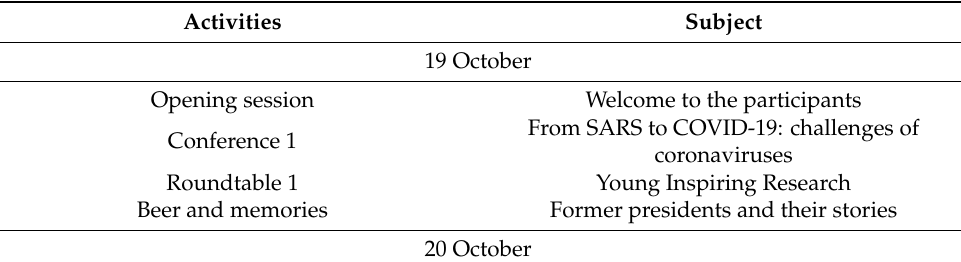
Table 1. Scientific programming schedule of the 32nd Brazilian Society of Virology